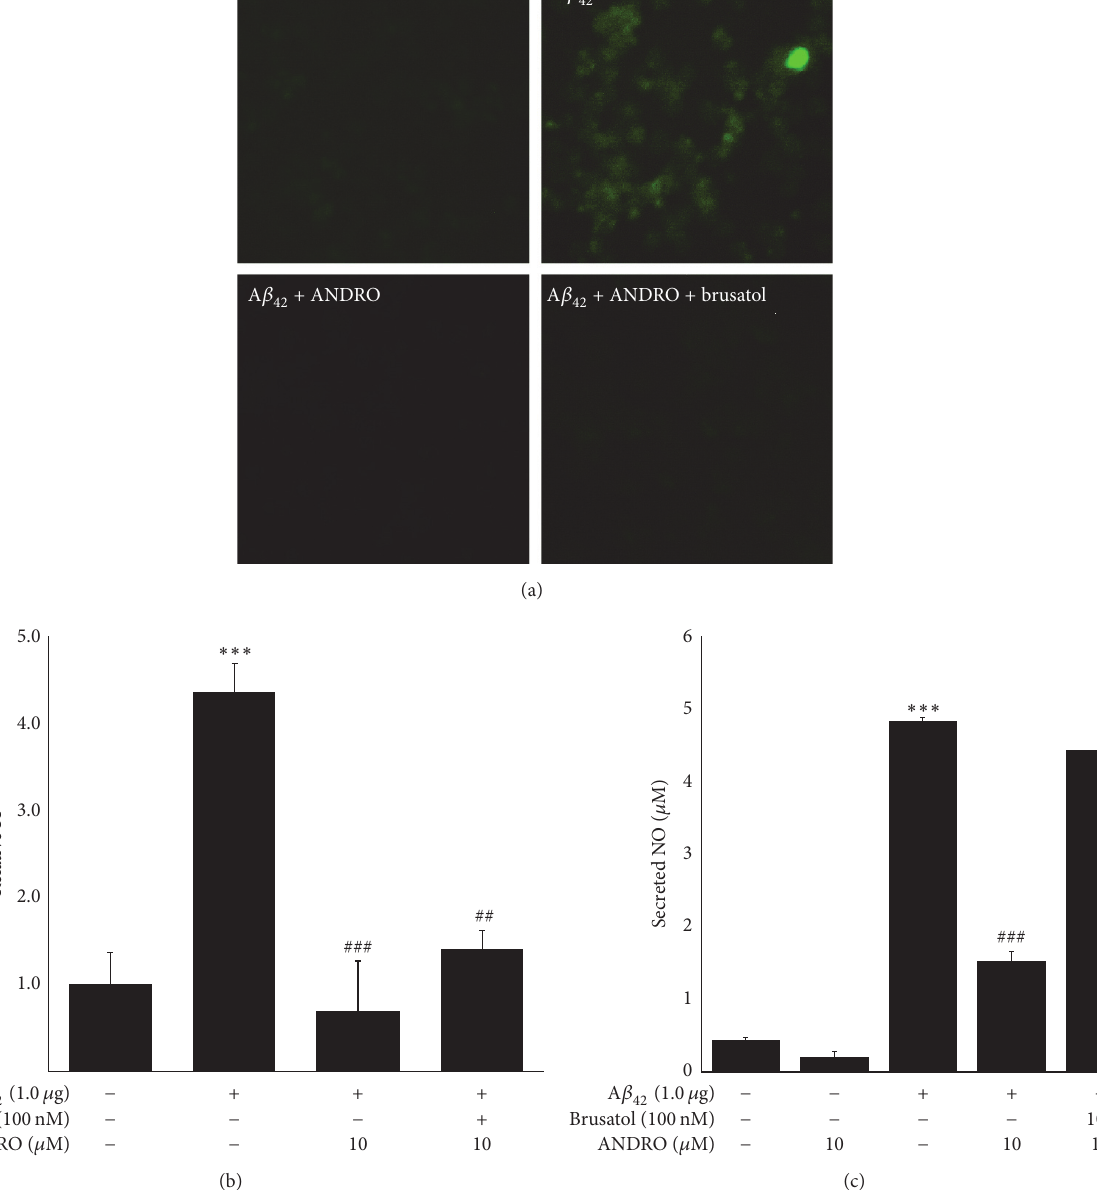
Figure 4: Effect of andrographolide and/or brusatol on A 𝛽 42 expression in BV-2 cells. BV-2 cells were transfected with A 𝛽 42 plasmids for 12h. The medium was discarded and replaced with phenol red-free medium in the absence or presence of 100nM brusatol. After 2 h, the medium was replaced with fresh medium containing 1, 5, or 10 𝜇 M of andrographolide. The abbreviation of andrographolide, ANDRO, was used. (a) The microglial clearance of A 𝛽 42 was visualized by fluorescence microscope imaging. (b) The relative fluorescence intensity of A 𝛽 42 was quantified by Image J software. The data are presented as the means ± SE of triplicates. The significance presented as ∗∗∗ 𝑝 < 0.001 compared with control group and ## 𝑝 < 0.01 and ### 𝑝 < 0.001 compared with the A 𝛽 42 -transfected group. (c) The secreted NO levels in the medium of BV-2 cells were measured using the Griess method. The data are presented as the means ± SE of triplicates. The significance presented as ∗∗∗ 𝑝 < 0.001 compared with control group and ### 𝑝 < 0.001 compared with the A 𝛽 42 -transfected